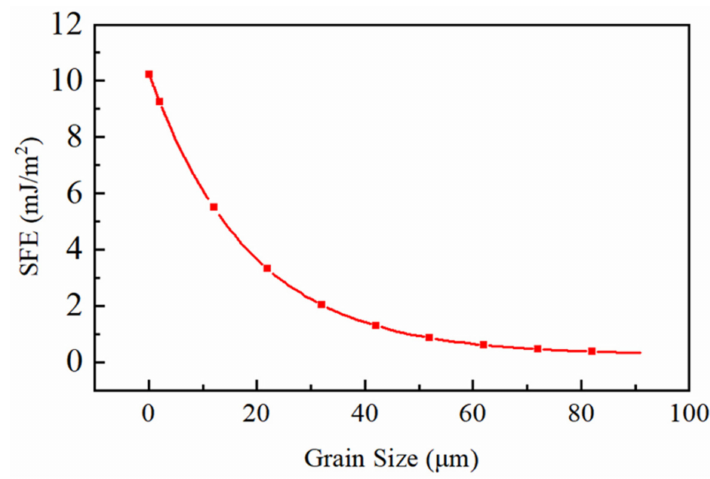
Figure 6. Influence of grain size on SFE of 0B steel.